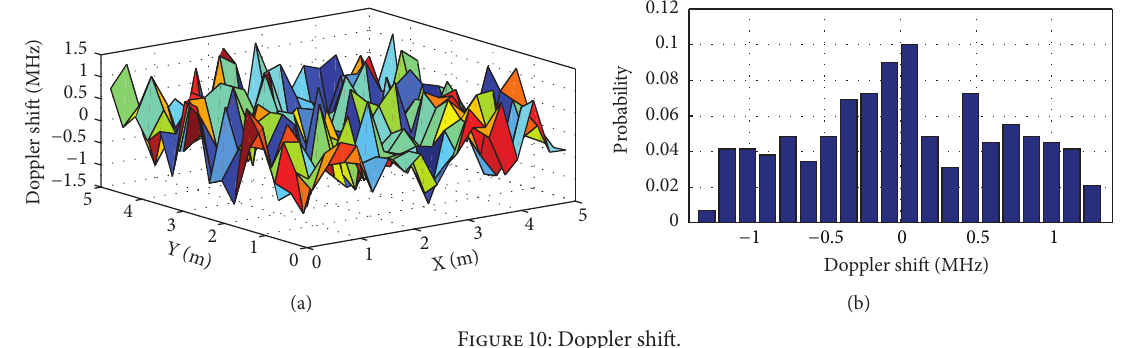
Figure 9: Mean angle of arrival.